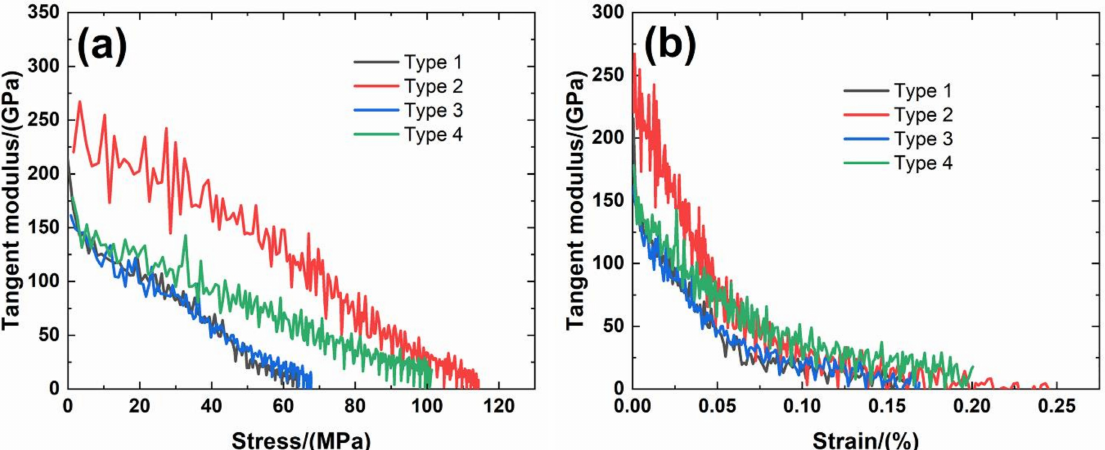
Figure 7. ( a ) Composite tangent modulus versus applied stress curves; and ( b ) composite tangent modulus versus applied strain curves of four different types of 3D needle-punched C/SiC